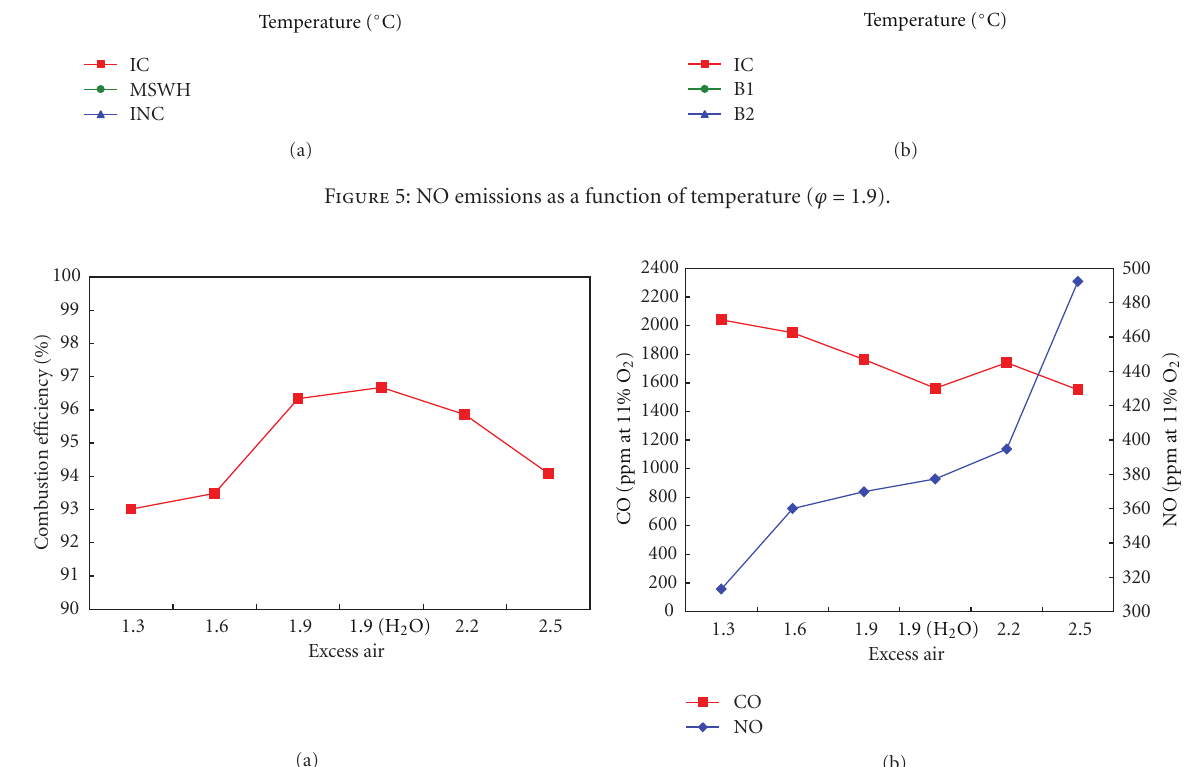
Figure 6: Combustion behaviors of B1 at di ff erent conditions (at 900 ◦